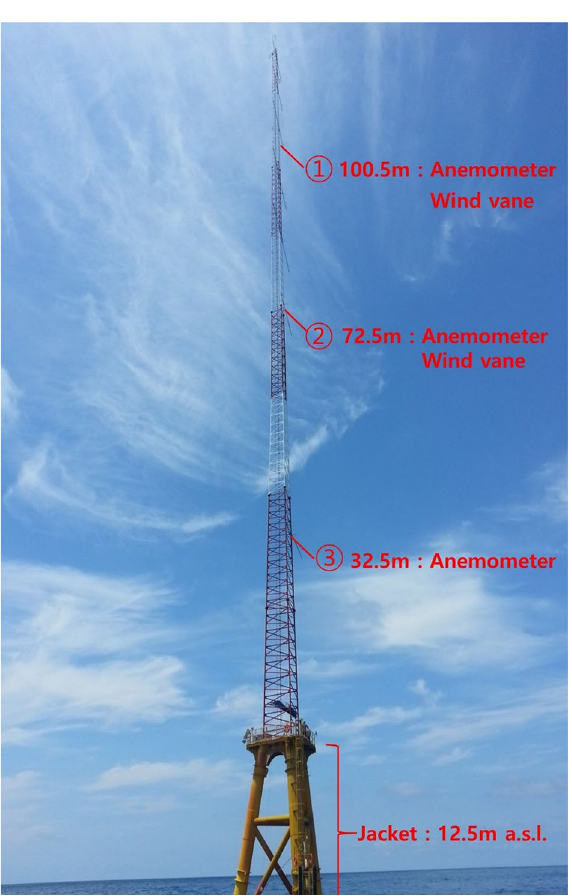
Figure 2. Measurement heights of wind sensors on the offshore met mast attached on jacket type